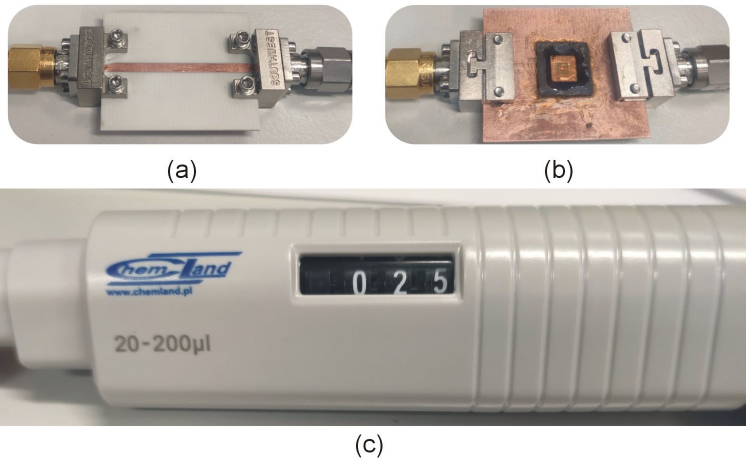
Figure 13. Measurement setup: ( a ) top view of the sensor, ( b ) bottom view with PLA container and oil under test, and ( c ) single ‐ channel adjustable volume pipette used for volume control of the oils.